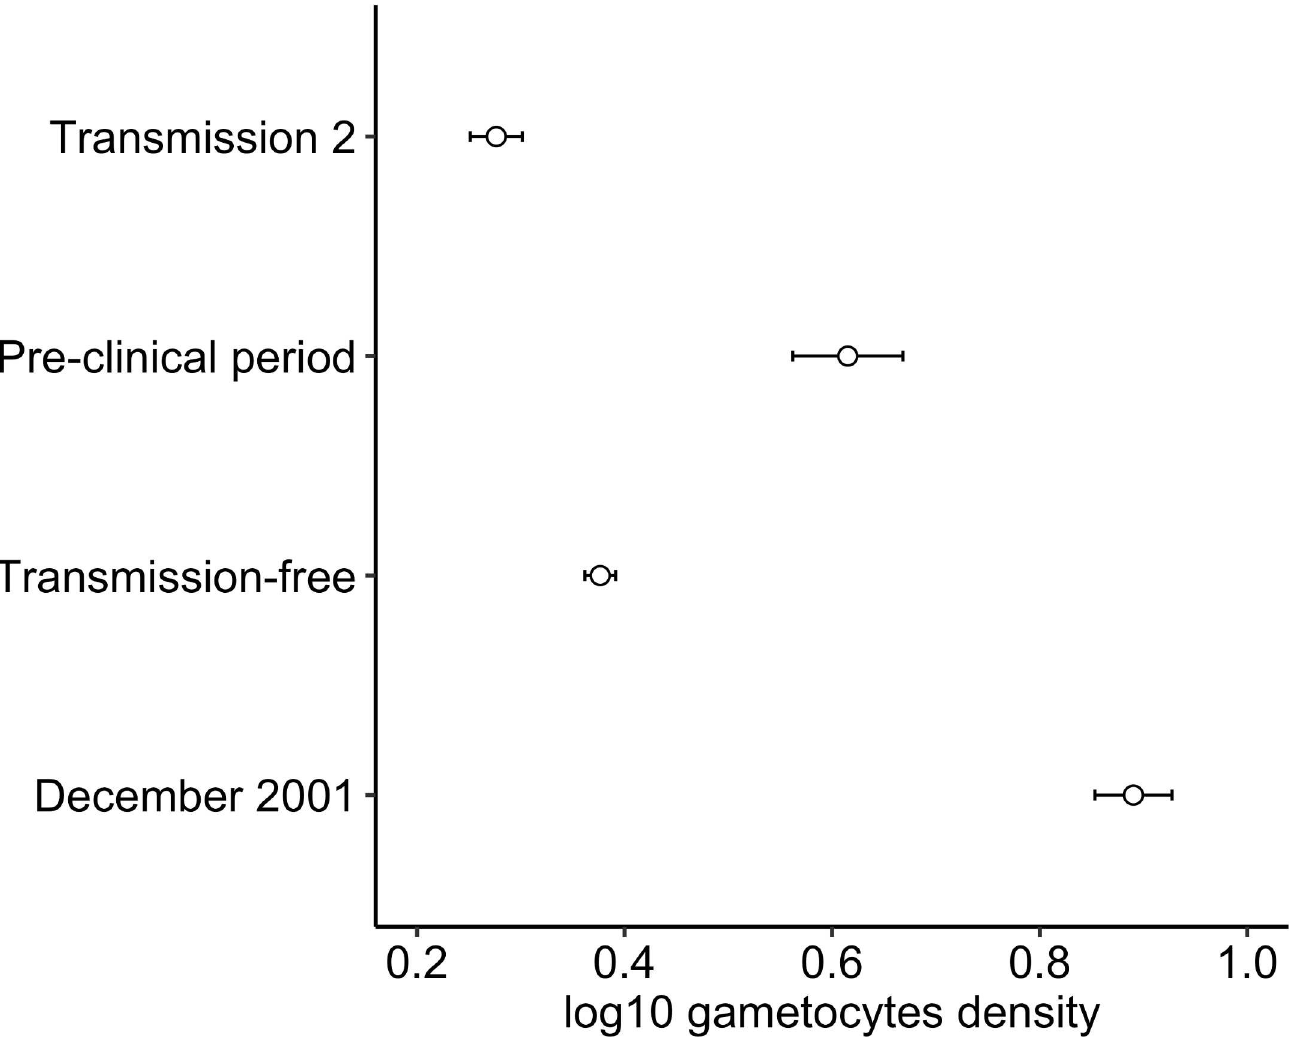
Fig 2. Association between gametocyte density and season. Gametocyte density, as predicted by the best-fit model, is significantly higherin the pre-clinical season comparedto the transmission-free season and transmission season 2. Error bars representthe standard error of the mean. Gametocyte density is presentedin arbitrary units, denotedas μ L blood RNA and is not directly comparable to total parasite density due to differences in sample processingand normalization to different WBC